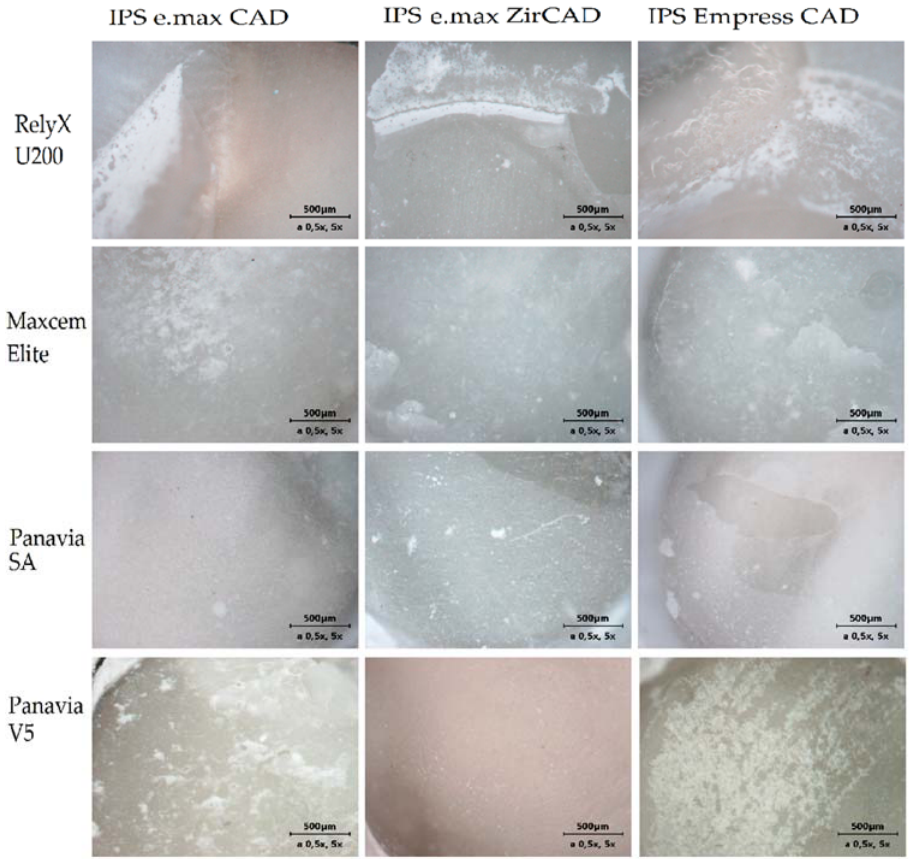
Figure 3. Light microscope photographs of different failure modes observed on dentin surfaces. Table 2. Quantitative results of failure mode analysis.